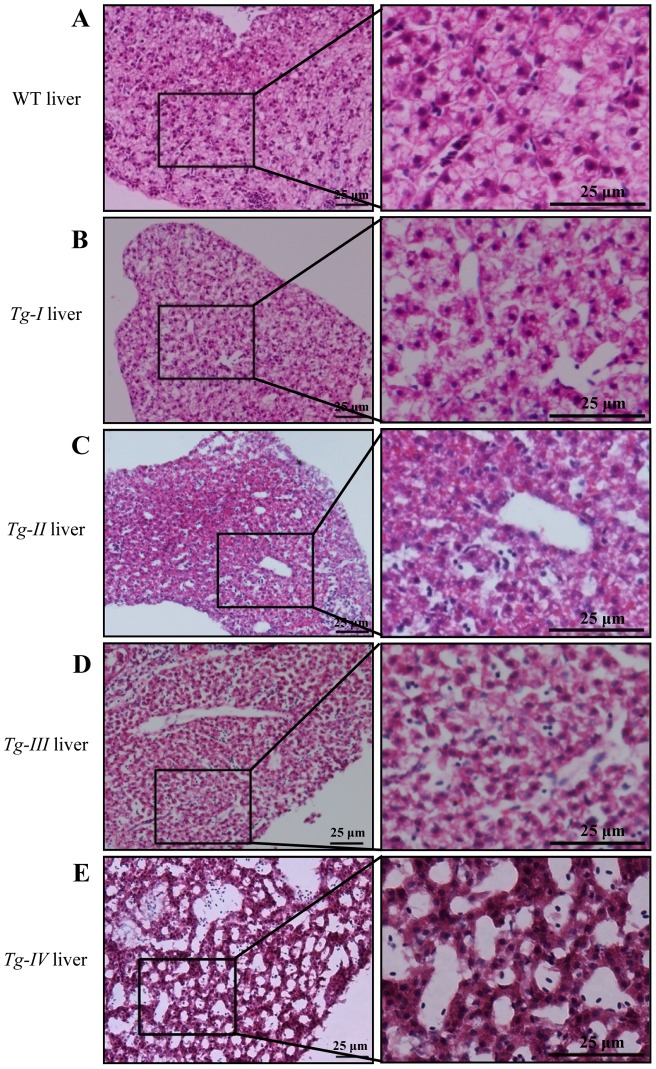
Def over-expression disrupts the intrahepatic structure.(A–E) H&E staining of the liver tissues from 3 months old fish of WT (A), Tg-I (B), Tg-II (C), Tg-III (D) and Tg-IV (E) showed that hepatocytes were loosely connected to each other and large gaps was formed in all four lines when compared to the liver tissue in the WT control. Panels on the left: view of the liver tissue at low power of magnification; panels on the right: high power of magnification view of the region boxed in the corresponding panels on the left as indicated.